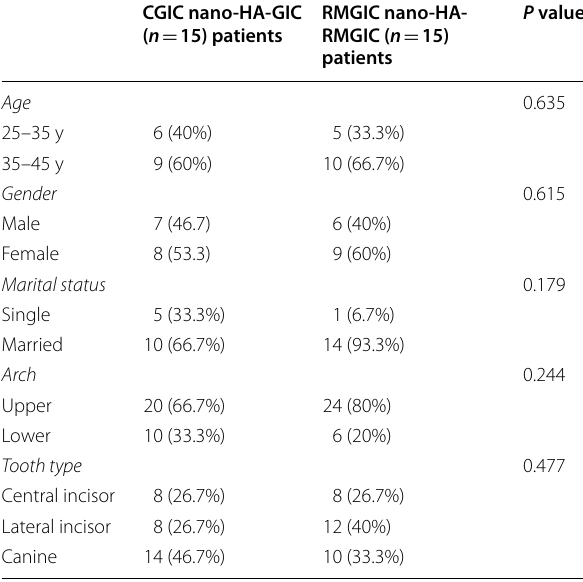
Table 3 Percentages (%), frequencies, and Chi-square test results for the comparison of the demographic data of the two tested main groups